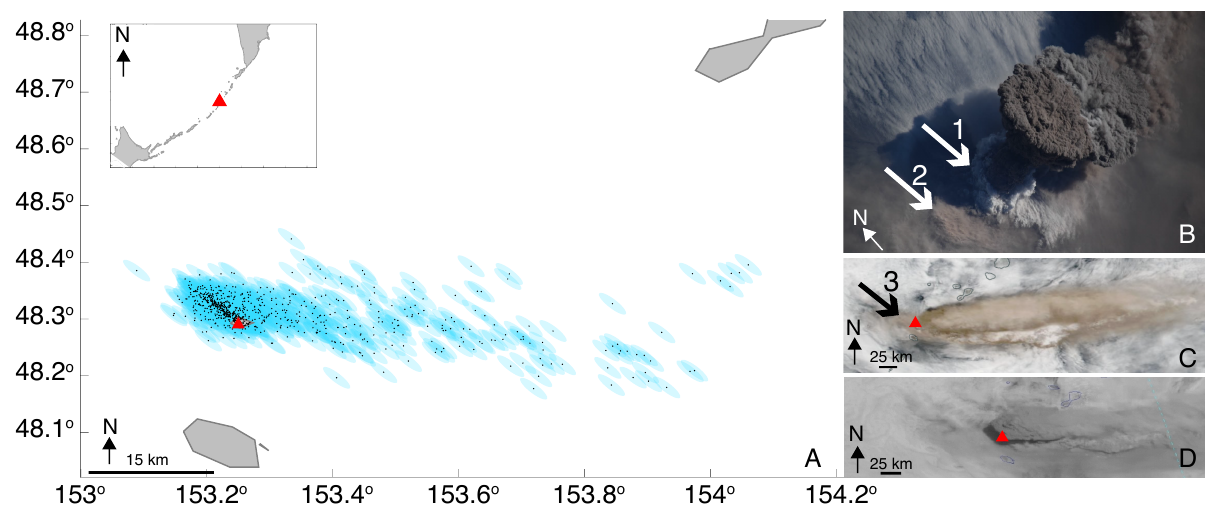
Figure 1: [A] Map of Raikoke volcano (red triangle) and volcanic lightning locations from 21-22 June 2019 (black dots) with associated location uncertainties (blue ellipses). Images show eruptive pulse 7 captured from [B] the International Space Station at 22:46 UTC on 21 June (NASA photo ID ISS059-E-119250 – no scale provided), [C] true color Suomi NPP/VIIRS, and [D] Himawari- 8 visible/band 3. Arrow 1 points to clouds associated with ground-hugging pyroclastic density currents that enveloped the island (Smirnov et al., 2021); arrows 2 and 3 point to a low-level ash cloud traveling to the northwest. of Biagi et al. [2007], who found that peak current